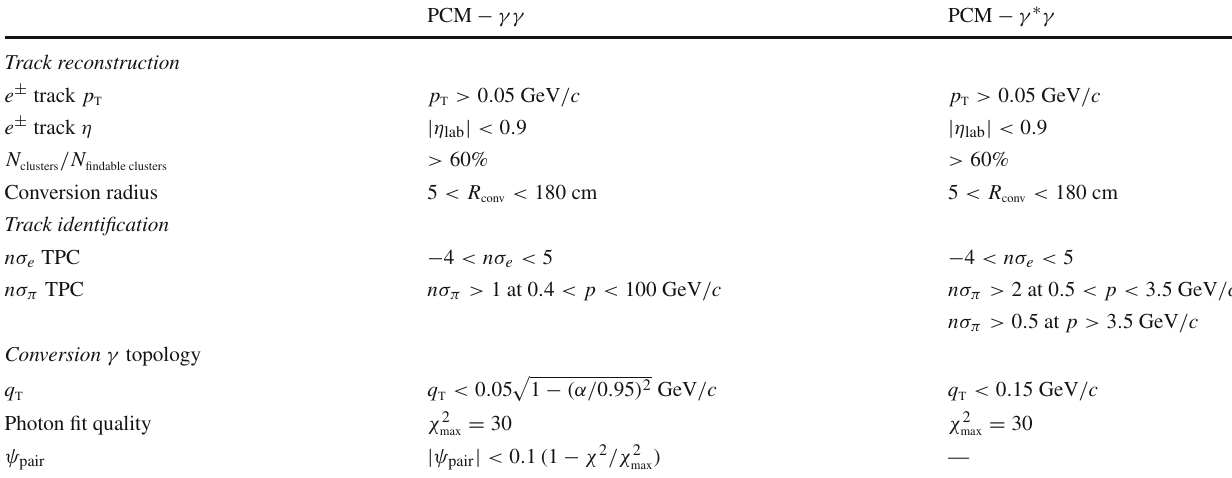
Table 1 Selection criteria of the converted photon reconstruction with PCM for the two-photon (PCM − γγ ) and the Dalitz decay